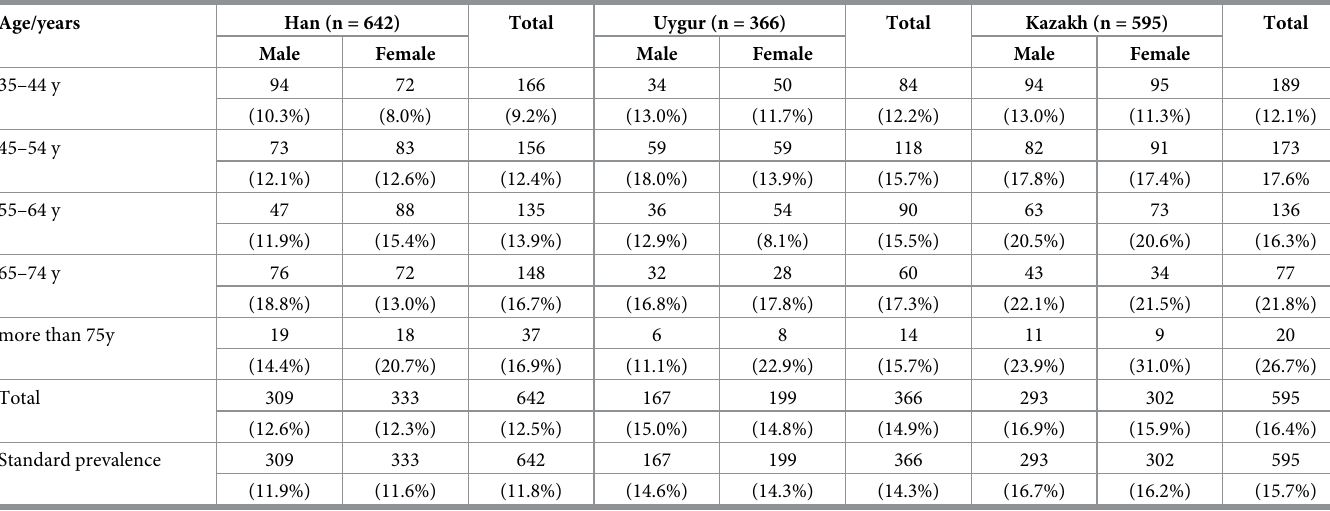
Table 3. Comparison of abnormal IAD prevalence rates of the general population among three ethnic groups (n, %).